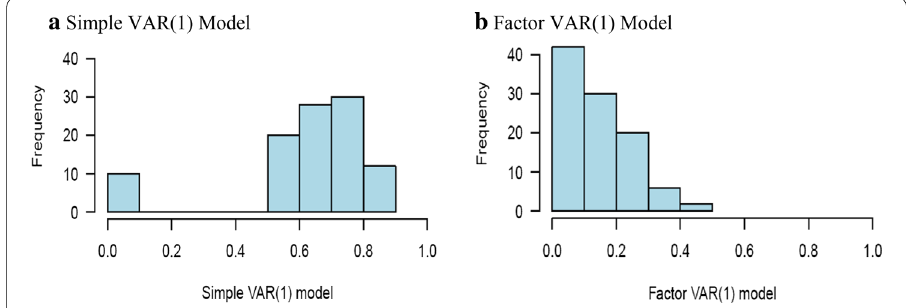
Fig. 1 Comparison of absolute residual correlations, with and without factors. a Simple VAR(1) model. b Factor VAR(1) model. Note: The histograms show the distribution of the absolute pairwise correlations between the residuals of the simple VAR(1) model and our factor VAR(1) model evaluated by OLS